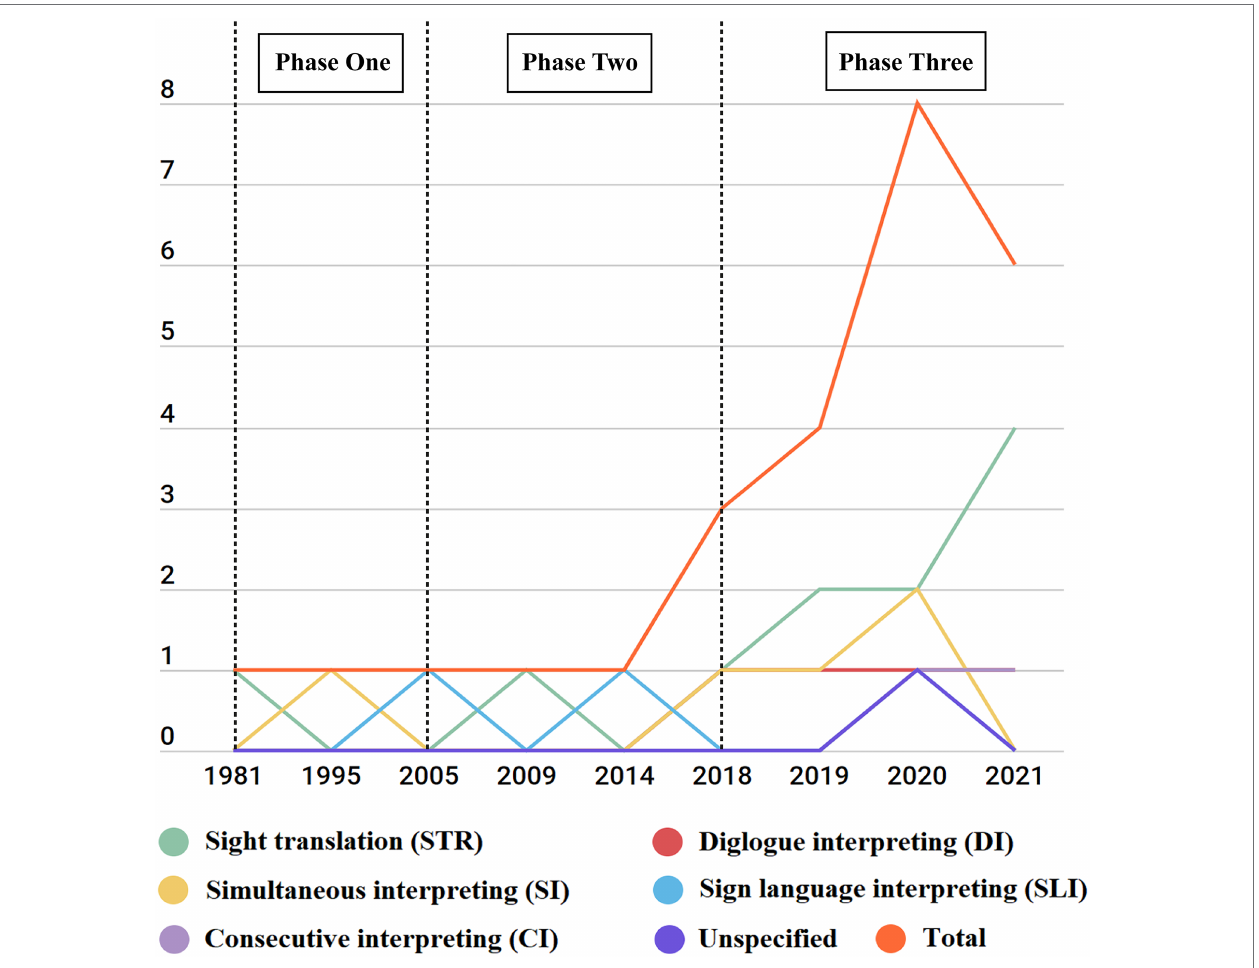
FIGURE 2 | Phases of